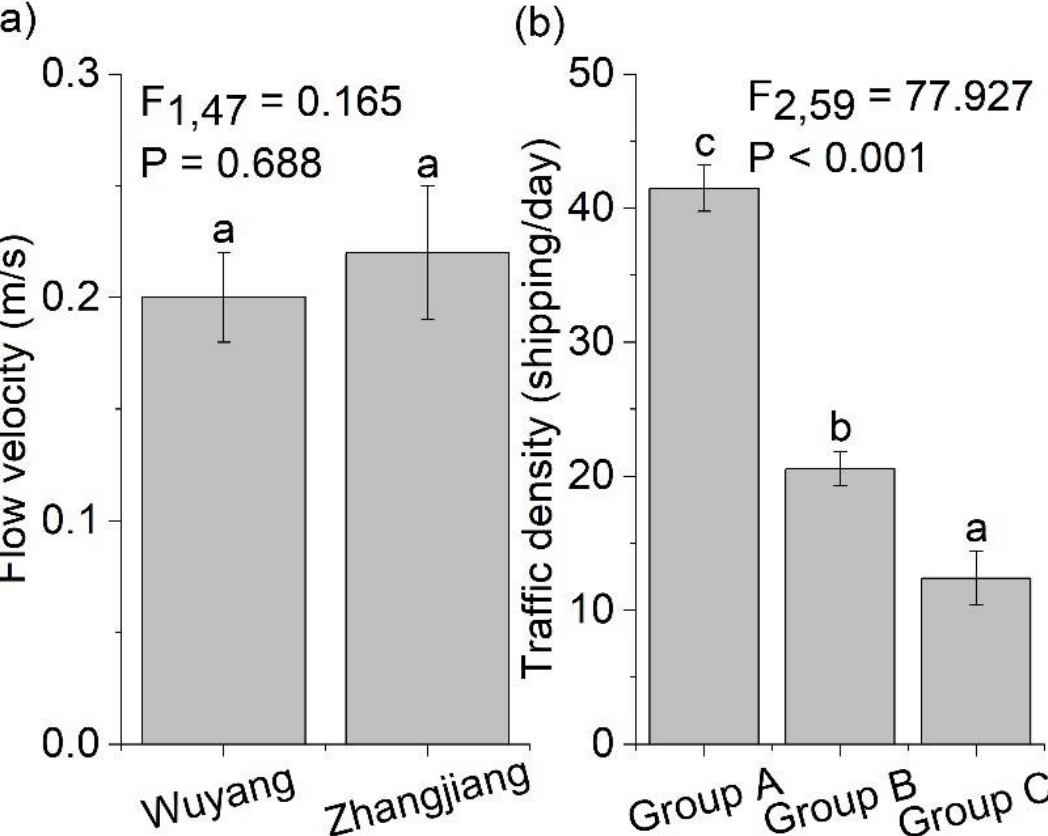
Figure 2. The environmental parameters in the study area, including ( a ) the flow velocity in the Wuyang river and the Zhangjiang river, and ( b ) the traffic density in the groups. Data are expressed as the mean ± SE and letters indicate significant differences based on Tukey’s post hoc tests.